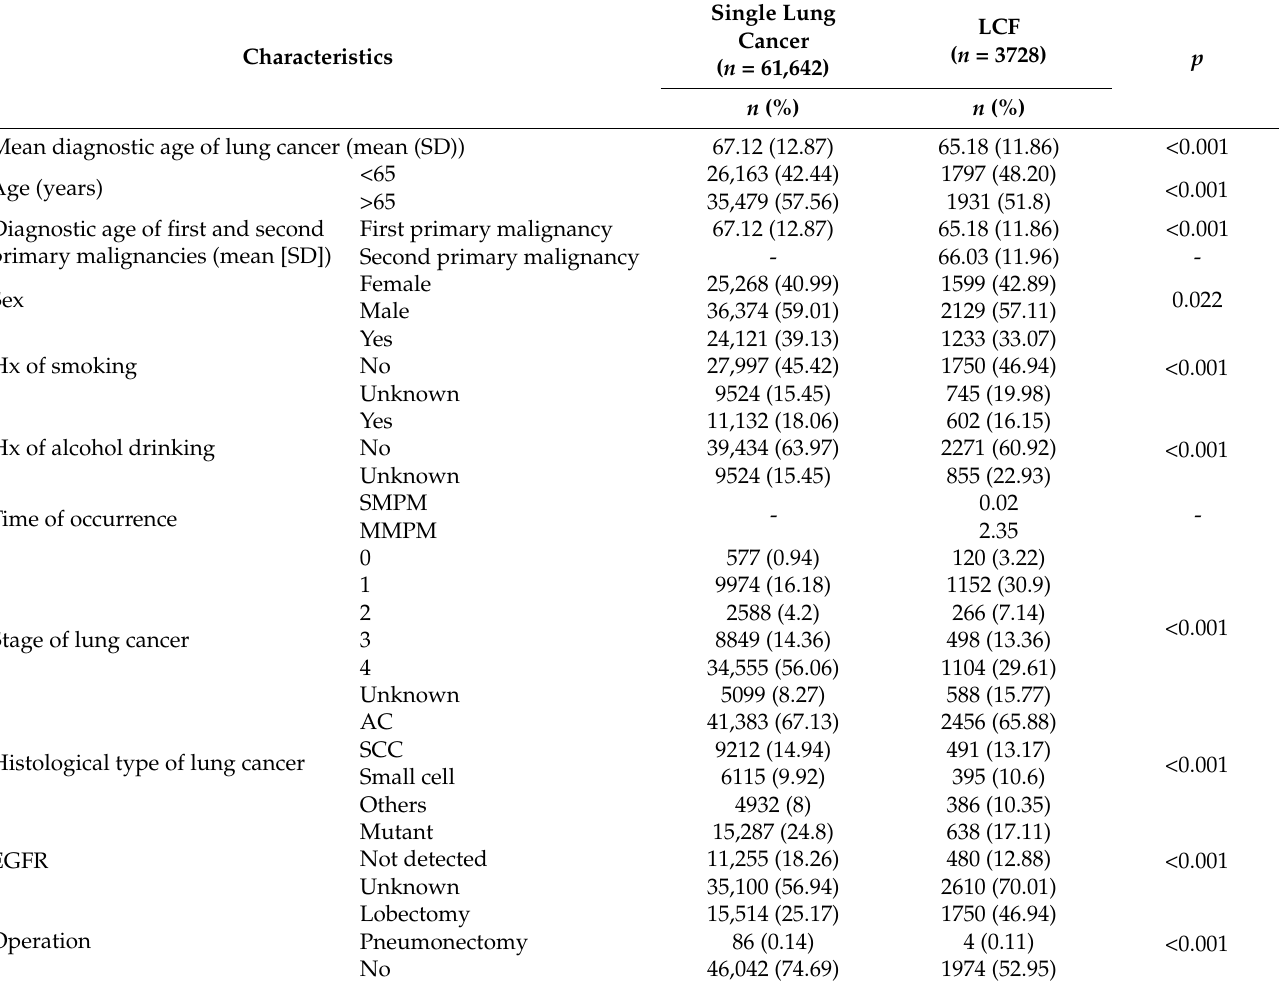
Table 2. Characteristics of patients with single lung cancer and